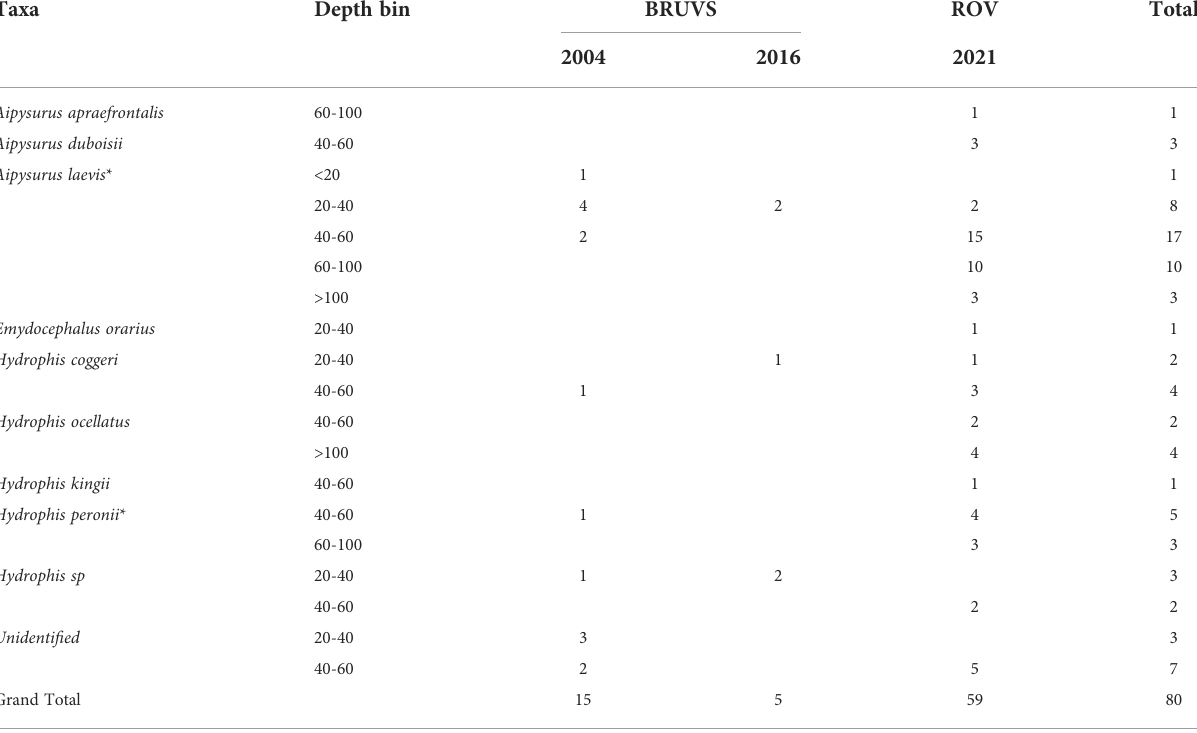
TABLE 1 Sea snake taxa identi fi ed at Ashmore Reef using BRUVS surveys in 2004 and 2016, and a ROV survey in 2021.